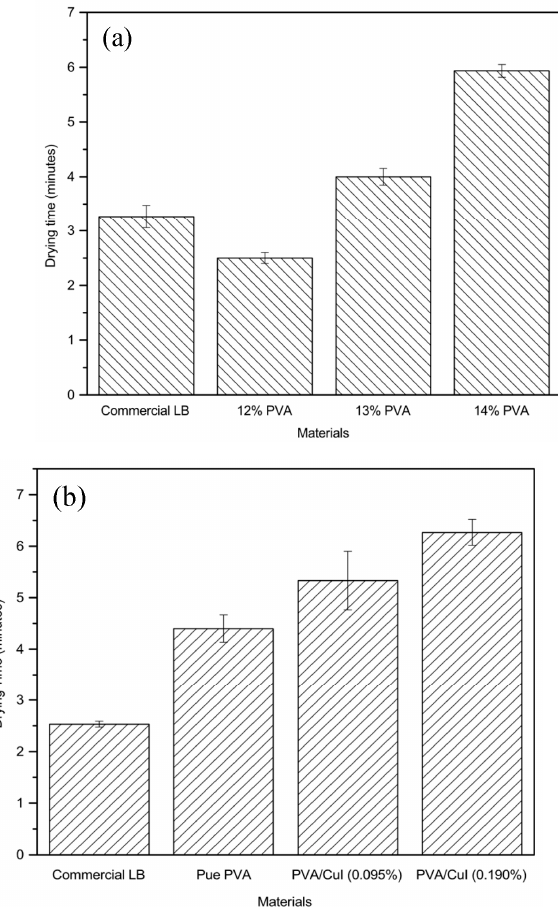
Figure 12. Drying time of film compared with a commercial liquid bandage (LB): ( a ) content of PVA; ( b ) PVA composed of CuI suspension.